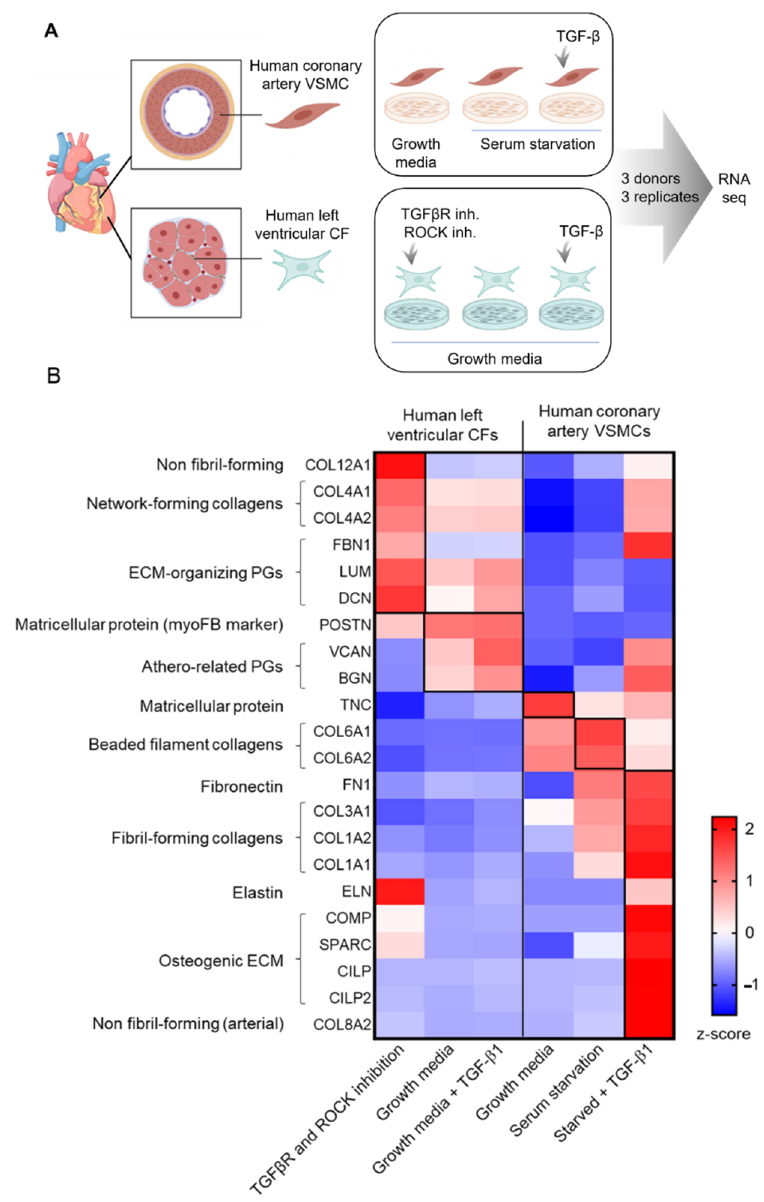
Figure 2. Extracellular matrix (ECM) gene expression in primary human cardiac fibroblasts and primary human coronary artery vascular smooth muscle cells varies in different in vitro phenotypes. ( A ) Schematic overview of cell types used and experimental set-up. Commercially available human